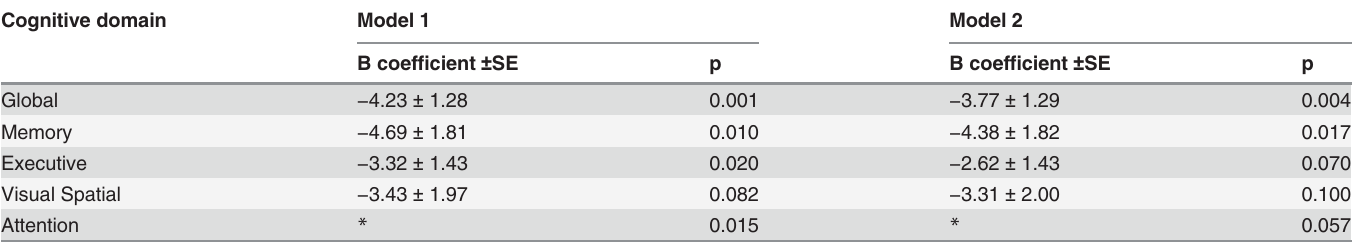
Table 2. Linear Regression Model of association between low UA (bottom quintile vs. higher) and cognitive performance. Cognitive domain